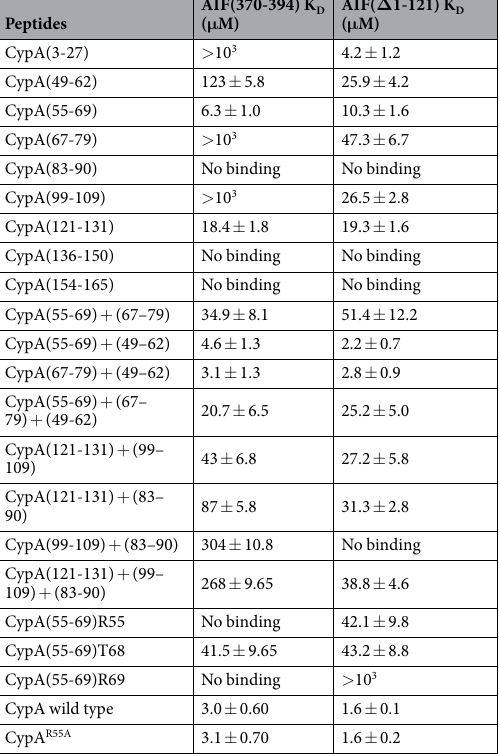
Table 1. Comparison of AIF( Δ 1-121) and AIF(370-394) binding affinities for the CypA peptides